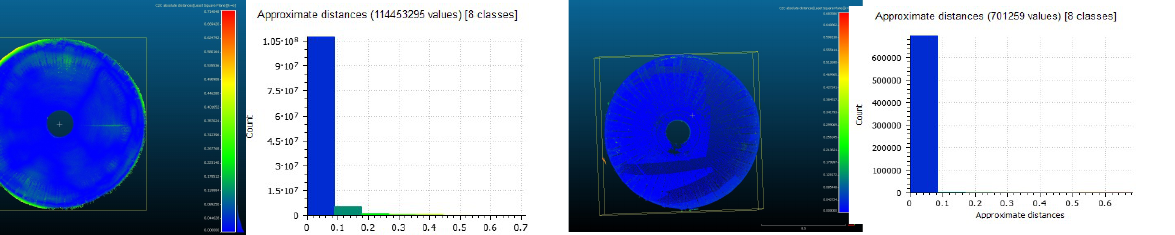
Figure 13: Discrepancy (m) map and histogram between the TLS point cloud and Regard 3D